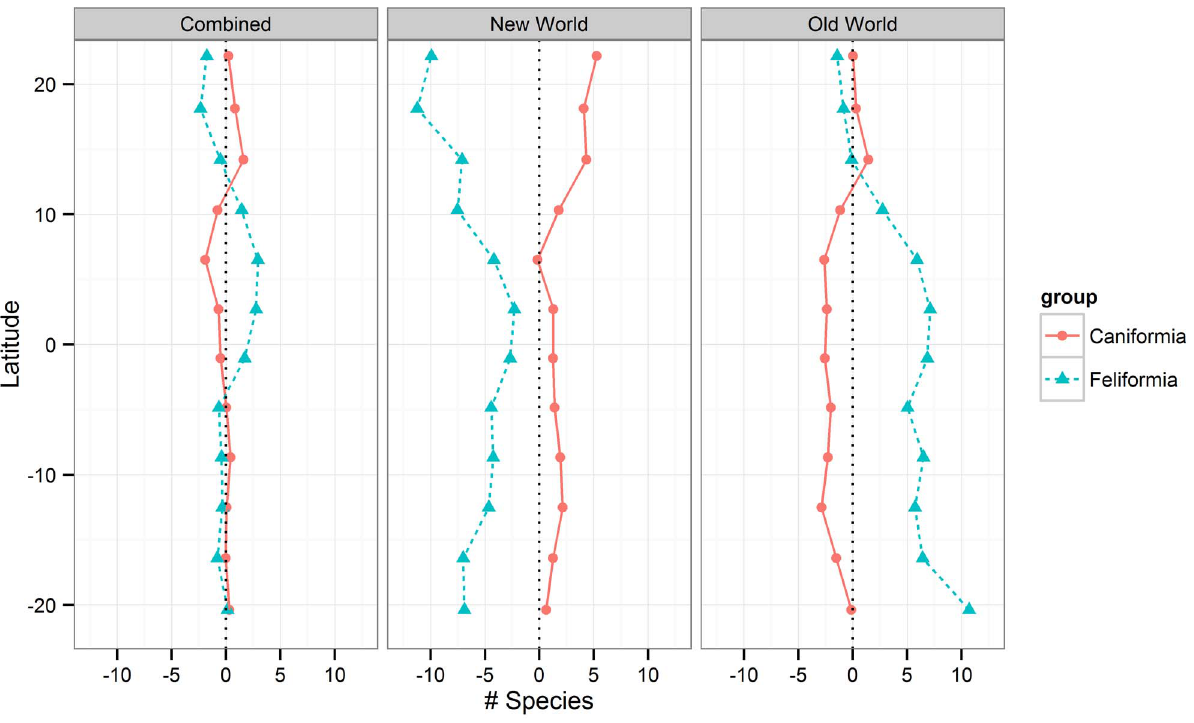
Figure 4. The residual number of species per cell of the ordinary least squares (OLS) models of the clade species richness against the environmental predictors. Plotted against a latitudinal gradient for both the Caniformia and Feliformia models run on all environmental predictors.